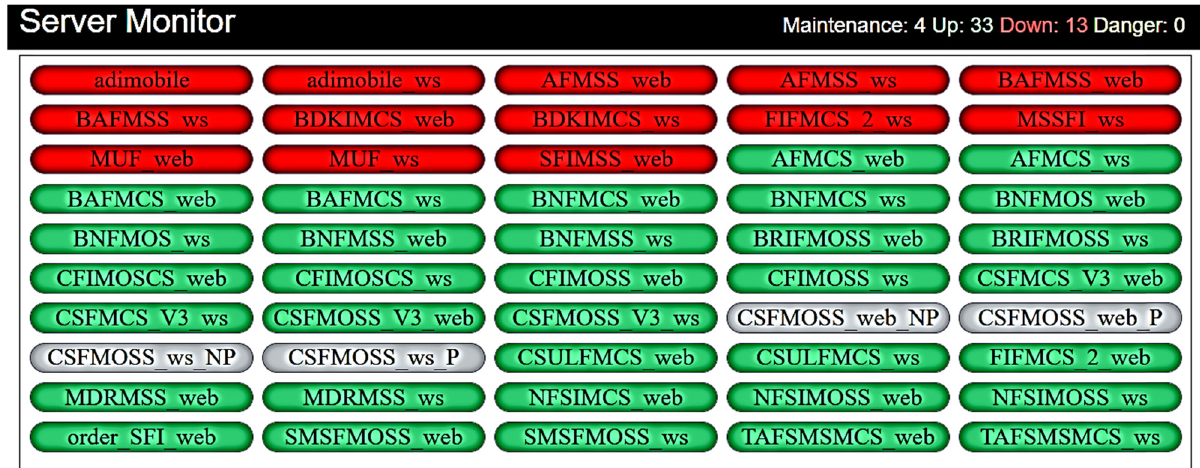
Figure 3: List of web application